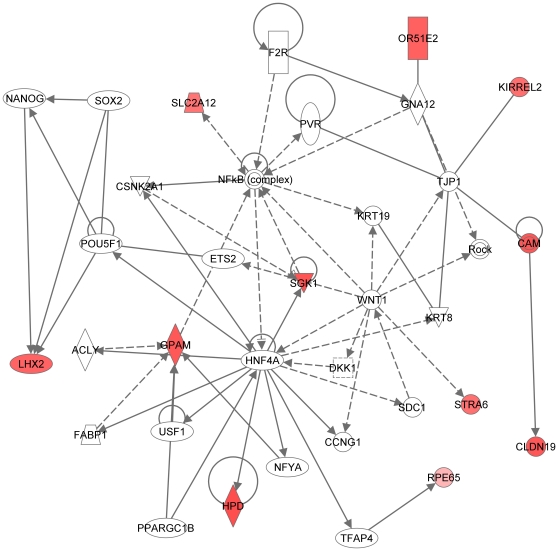
Fourth significant molecular network generated by Ingenuity.Network is generated from our microarray dataset with RPE-specific expression (114 entries; see text). For explanation of symbols on the diagrams see legend Figure 7. This network overlaps with the network in Figure 7. The main functionalities given by Ingenuity for this molecular network are lipid metabolism, molecular transport and nucleic acid metabolism. The highlights of this network include: The central roles for (a) the HNF4A transcription factor and (b) the NFkappa Beta and (c) Wnt signaling pathways.